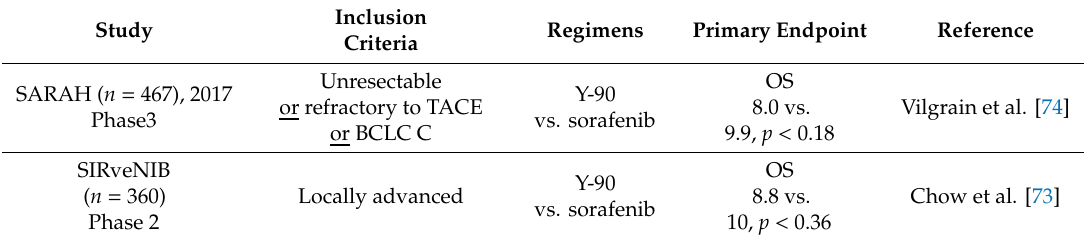
Table 2. Randomized trials comparing transarterial radioablation with systemic therapy.